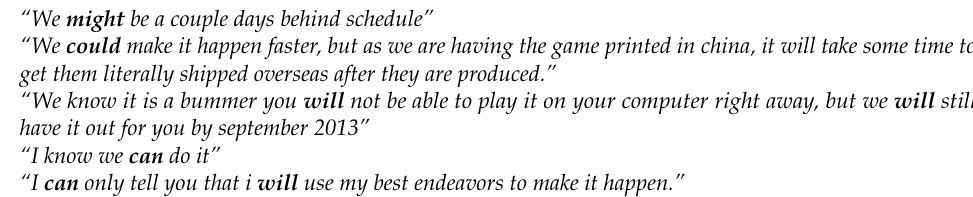
Table 4. Scammers’ comments using modal verbs: